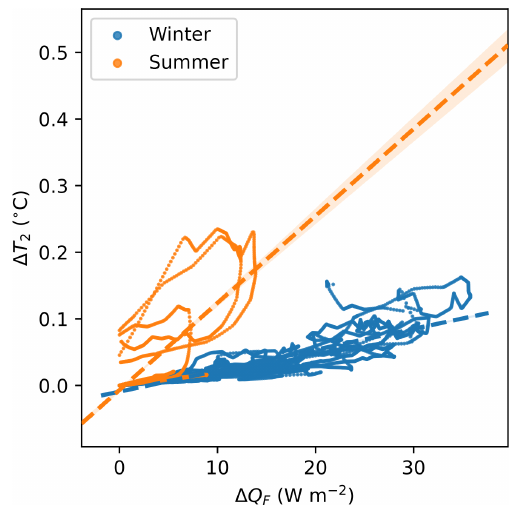
Figure 6. Impacts of increasing background (constant flux layer) air temperature T a on near-surface maximum, mean and minimum (same methods as Fig. 5) temperatures at 2m T 2 . Albedo is 0.1 and land cover characteristics are as in Table 2b. Note that in this example only one variable is modified.